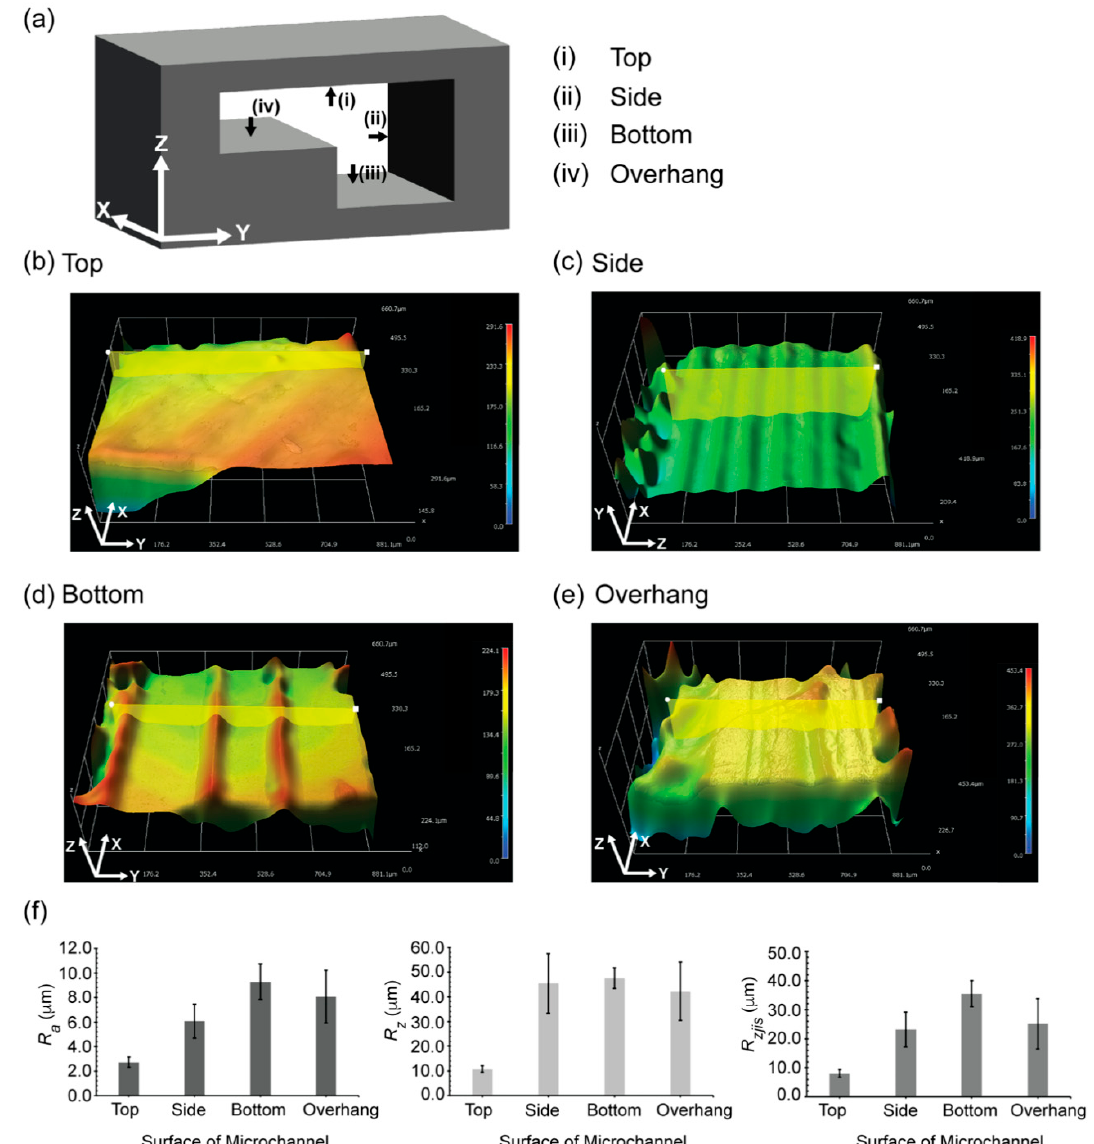
Figure 4. 3D profile of the surfaces of the microchannel fabricated by dual sacrificial molding of HIPS and PVA mold. ( a ) Schematic of the cross section of the microchannel with an overhang feature. Four surfaces of the microchannel were analyzed to study surface roughness: (i) the top surface of the microchannel, (ii) the side wall of the microchannel, (iii) the bottom surface of the microchannel and, (iv) the bottom surface of the overhang feature; ( b ) 3D profile of the top surface of the microchannel; ( c ) 3D profile of the side wall of the microchannel; ( d ) 3D profile of the bottom surface of the microchannel; ( e ) 3D profile of the bottom surface of the overhang feature of the microchannel; ( f ) Plots showing three parameters to characterize surface roughness: (left) R a values representing the mean roughness of the surface, (middle) R z values representing maximum height of roughness of the surface and (right) R zjis values representing 10-point mean roughness of the surface profiled by HIROX software. The data are mean ± SD ( n = 6).